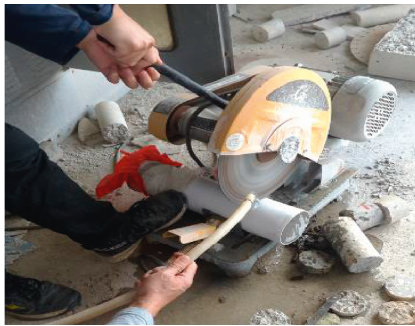
Figure 9: Cutting the sample.